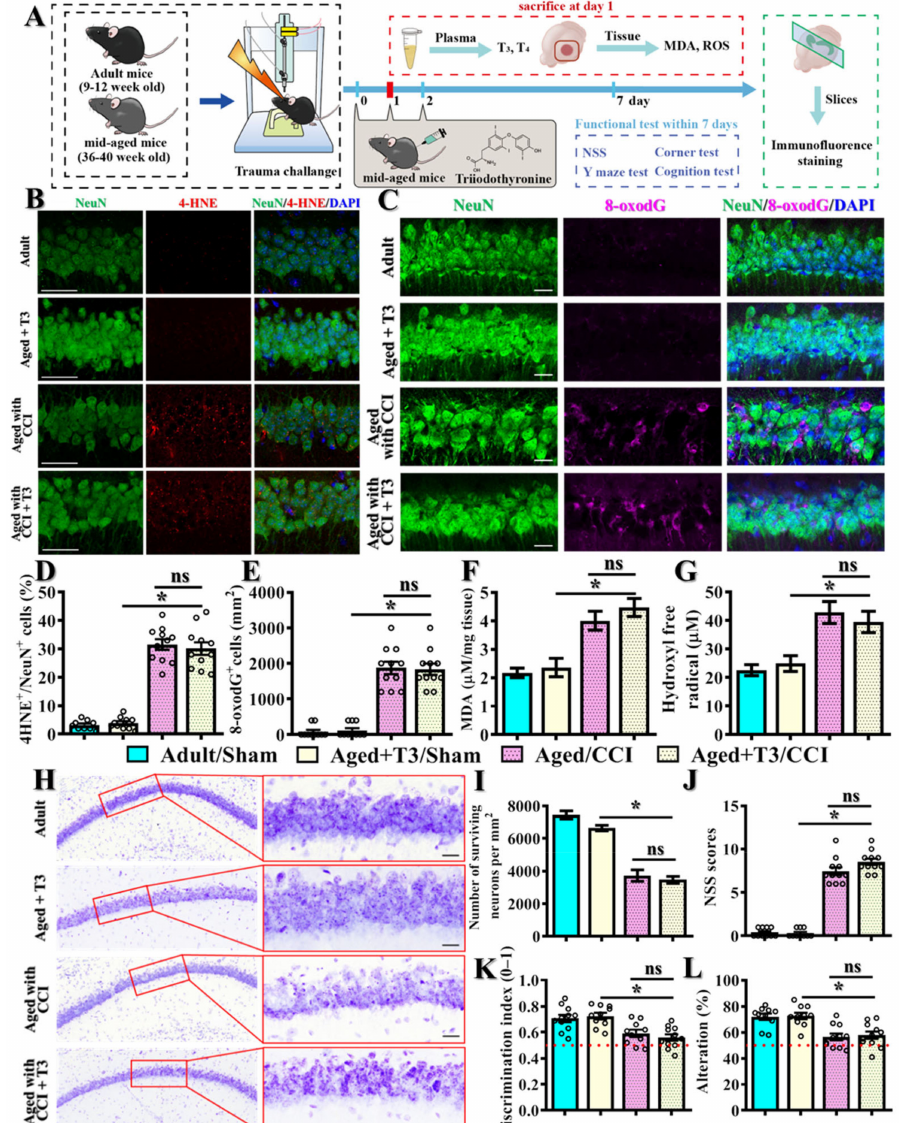
Figure 9. Acute T3 supplementation has no therapeutic benefits in TBI-susceptible phenotypes. ( A ) Schematic illustration of the experimental designs with acute T3 supplementation; ( B ) Represen- tative images of 4-HNE-positive (color in red) neurons (NeuN, color in green); ( C ) Representative images of 8-oxodG-positive (color in magenta) neurons (NeuN, color in green). Blue, DAPI signal for the nuclear stain. Scale = 25 µ m; ( D ) Quantification of the percentage of neurons with 4-HNE-positive puncta; ( E ) Quantification of the regional density of the 8-oxodG-positive neurons. n = 15 images from 5 mice in ( D , E ); ( F ) Quantification of the levels of malondialdehyde; ( G ) Quantification of the production of hydroxyl free radicals; ( H – I ) Representative images of the Nissl stains and quan- tification analyses showing the surviving neurons in the hippocampal CA1 region. n = 15 images from 5 mice; ( J ) Behavioral performance of neurological severity scores. Behavioral performance of cognitive function in the object location recognition task ( K ) and spontaneous alternation Y maze ( L ) from different experimental groups. n = 8 to 10 mice. All the data are presented as mean ± SEM and are analyzed by a one-way ANOVA with Bonferroni’s post hoc analysis. * p < 0.05; ns, not